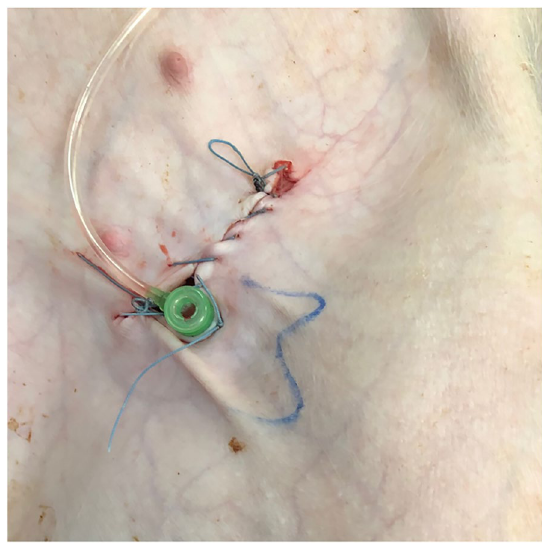
Fig. 1 PLL establishment in a healthy pig. After a transverse incision at the left groin, a 6-French vascular sheath accessed the left femoral artery under direct vision. Afterwards, the incision was sutured. The image was from Pig No.3 . Abbreviation: PLL, postoperative lymphatic